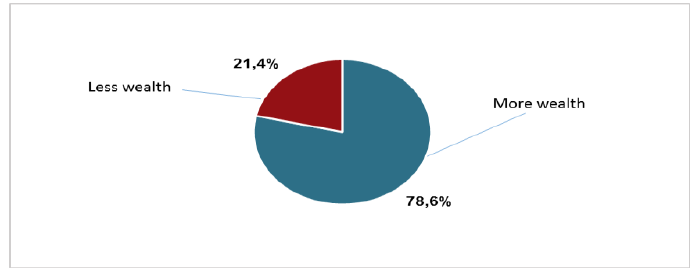
Fig. 4: Impact of ICT on GDP (With Fewer